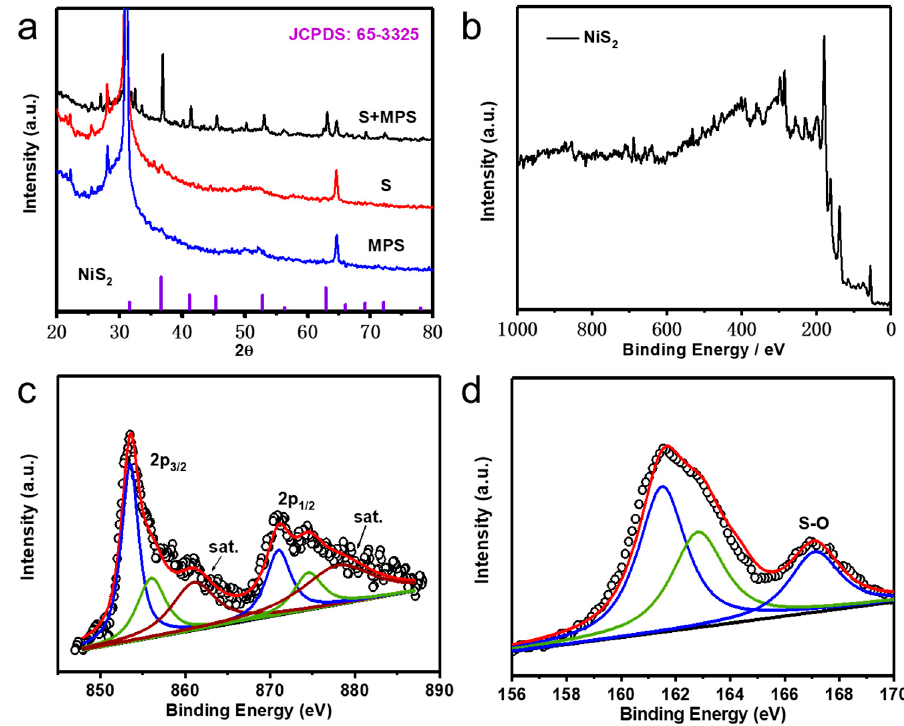
Figure 2. ( a ) XRD pattern of NiS 2 prepared from three different sulfur sources; ( b ) X-ray photoelectron spectroscopy (XPS) survey spectra of NiS 2 ; High-resolution XPS spectra of ( c ) Ni 2p, ( d ) S 2p of samples.